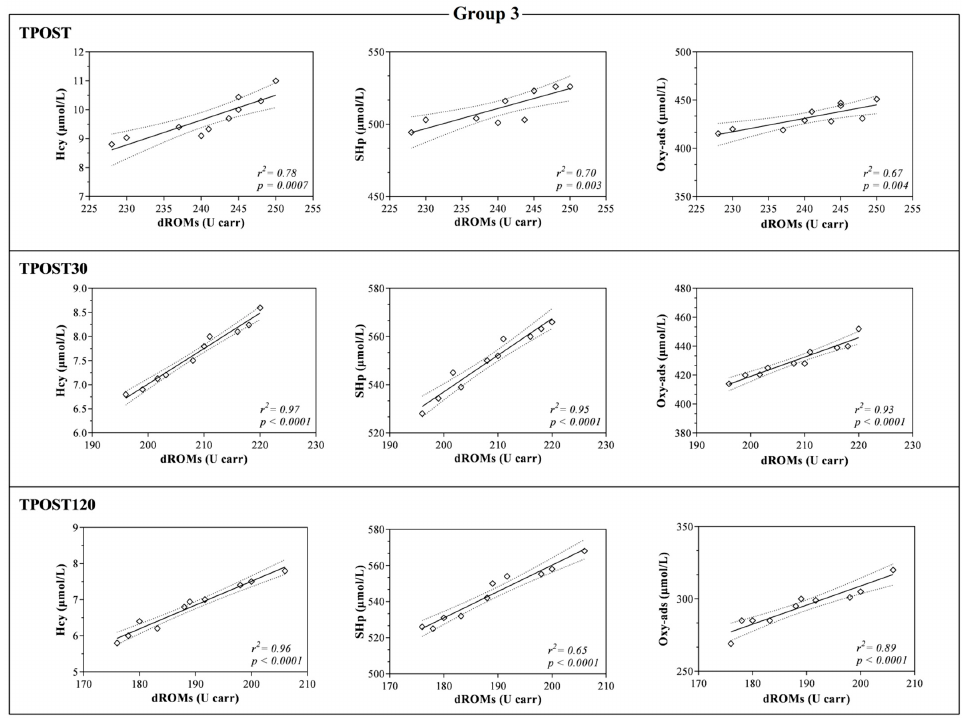
Figure 7. Linear regression values obtained between the serum concentration of reactive oxygen metabolites (dROMs) and the values of homocysteine (Hcy), thiol antioxidant barrier (SHp) and antioxidant barrier (Oxy-ads) obtained immediately after the race (TPOST), and after 30 (TPOST30) and 120 min (TPOST120) in Thoroughbred racehorses competing in 2000-m race (Group 3).